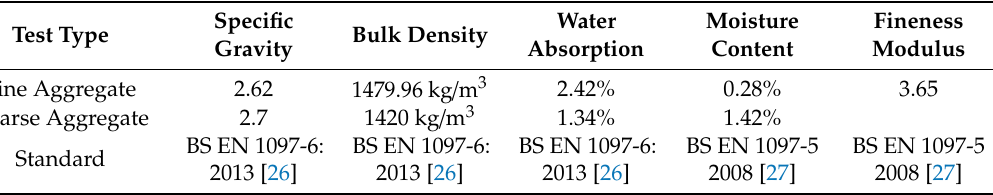
Table 1. Fine and Coarse Aggregate Properties.